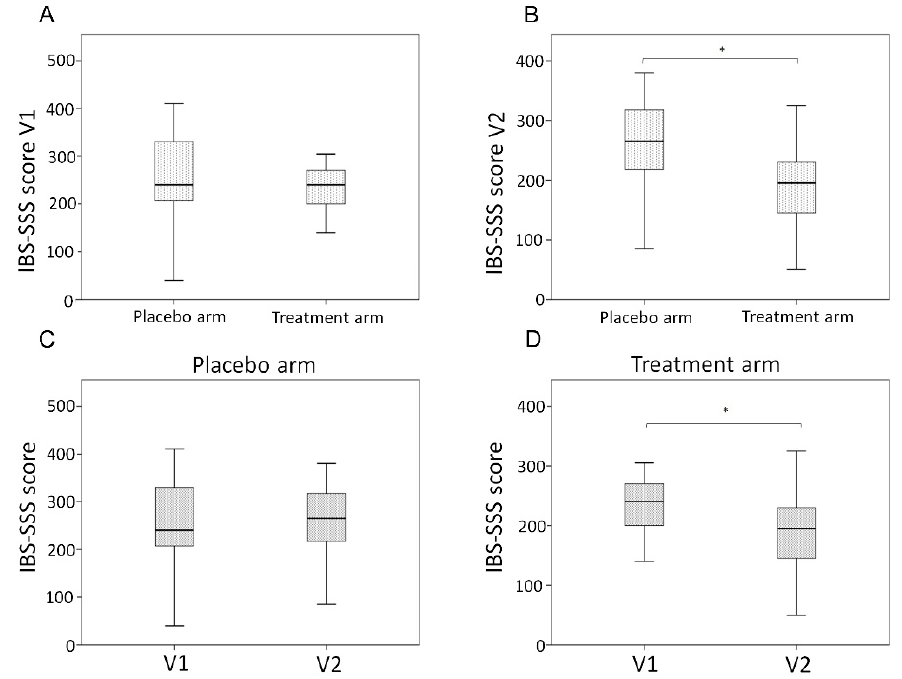
Figure 1. IBS-SSS at baseline ( A ), follow-up ( B ), and longitudinal evaluation according to study groups: placebo ( C ) and treatment arm ( D ). * p < 0.05.